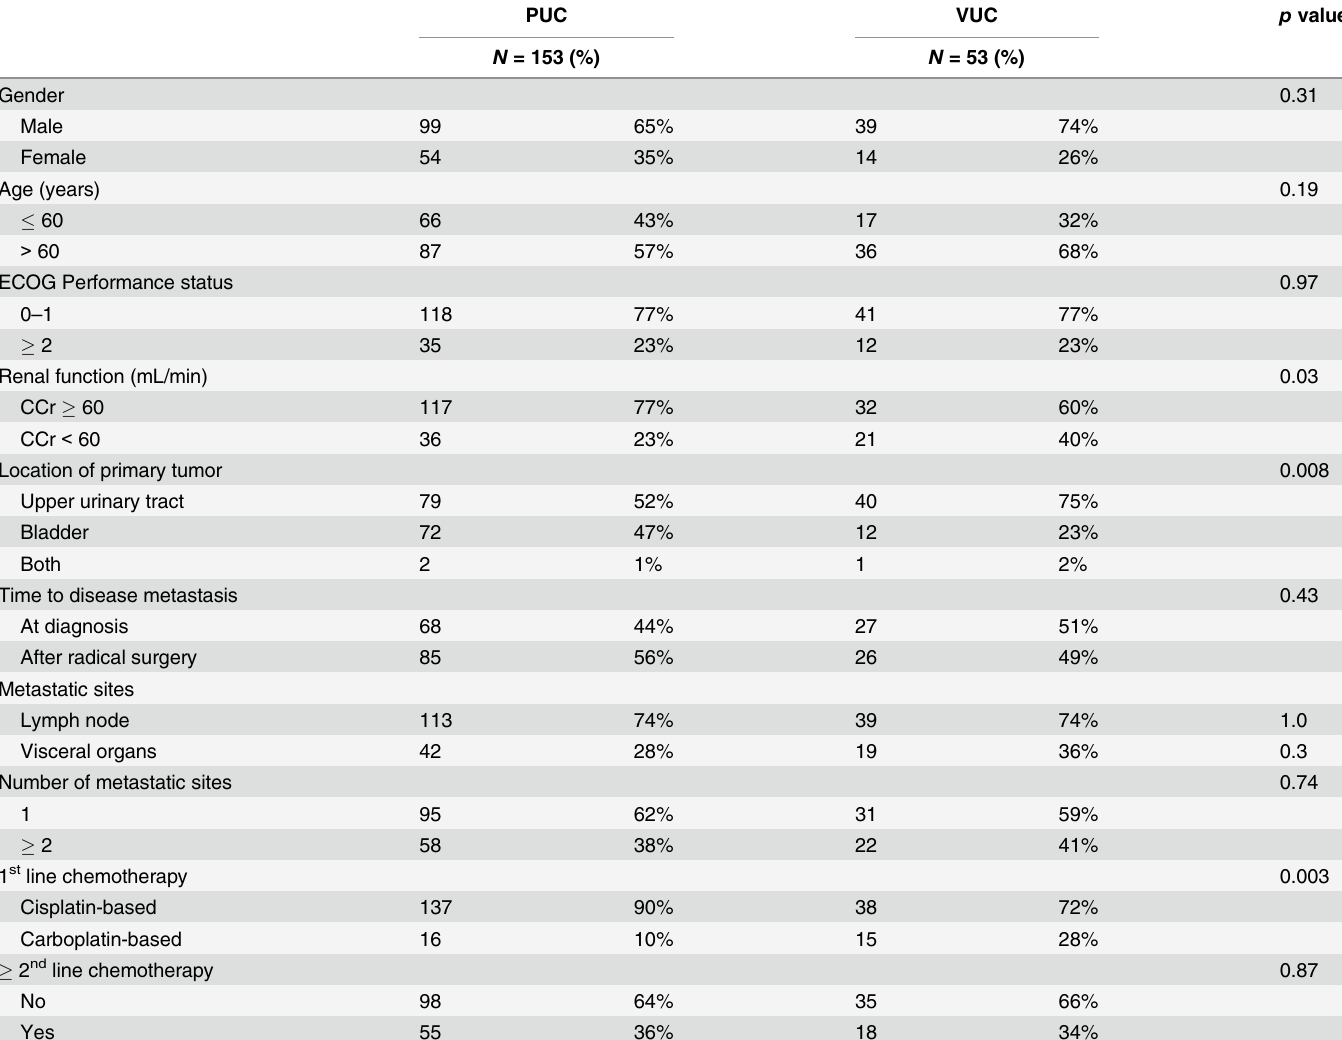
Table 1. Clinical characteristics of 206 patients with advanced urothelial